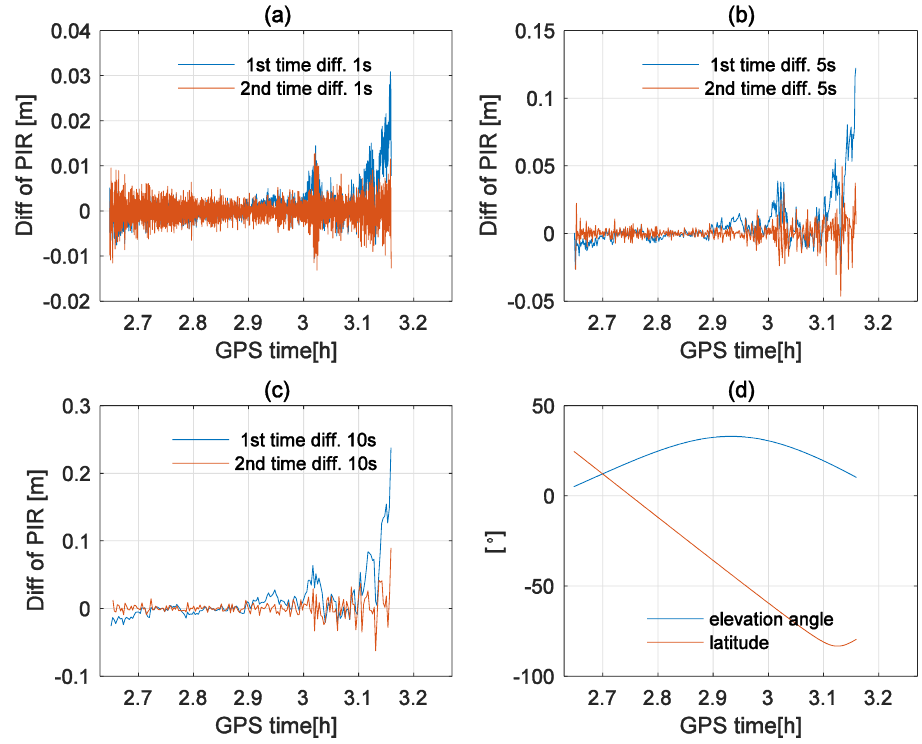
Figure 4. Time-difference phase ionospheric residual (PIR), elevation angle, and satellite latitude for GPS PRN 5 at GOCE on 26 November 2009, with different sampling intervals. ( a – c ) First- or second- order time-difference PIRs for 1 s, 5 s, and 10 s, respectively; ( d ) GPS satellite elevation angle and GOCE satellite latitude.